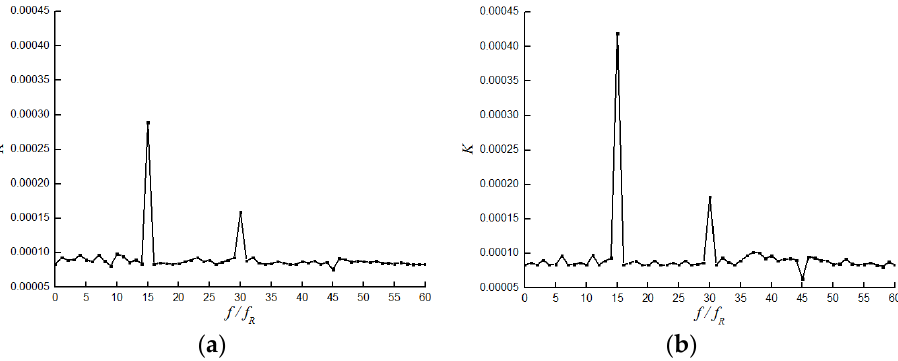
Figure 11. Frequency domain results of radial hydraulic forces. ( a ) Turbine suction. ( b ) Turbine impeller.